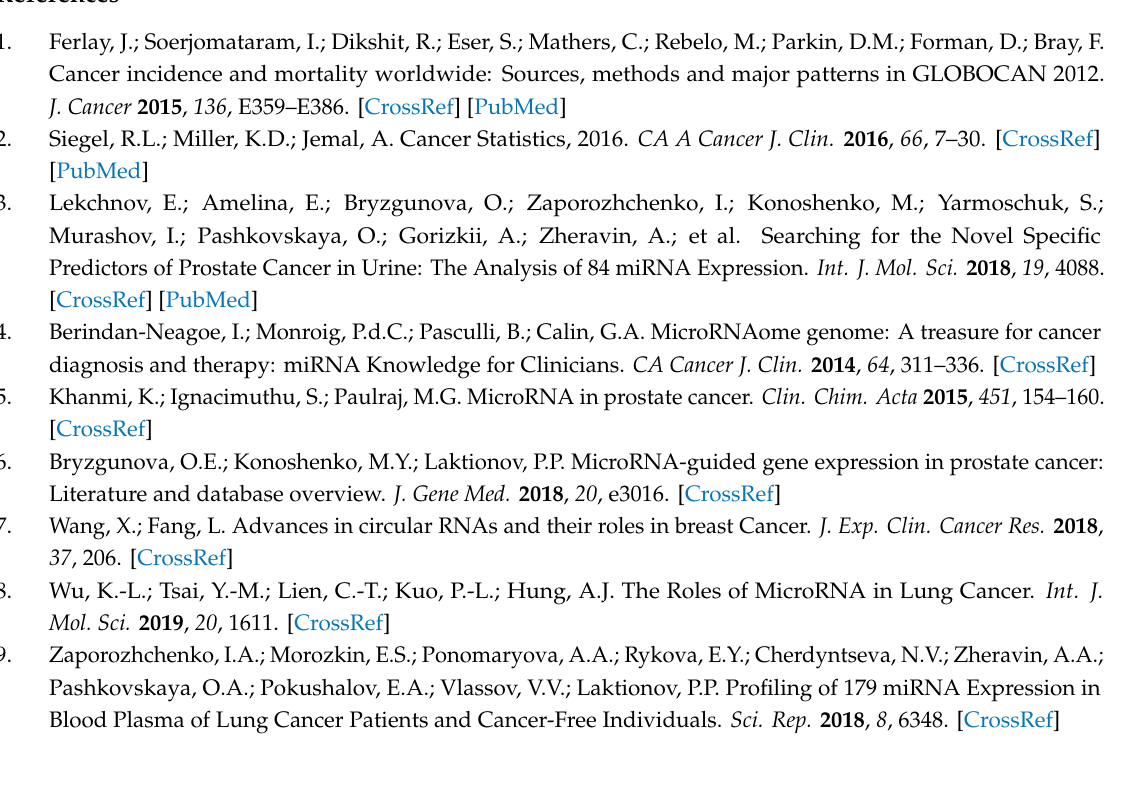
Supplementary Materials: The following are available online at http: // www.mdpi.com / 2075-4418 / 10 / 1 / 38 / s1, Table S1: Sequences of primers and probes used for reverse transcription and TaqMan qPCR, Figure S1: Examples of the qPCR curves for following miRNAs: miR-19b, miR-22, miR-92a, miR-378, miR-425 in urine EVs of healthy donor (A) BPH (B) and PCa (C) patients. Figure S2: Examples of the ROC curves for miRNA ratios with 100% specificity while discriminating PCa patients from healthy donors: (A) (100% sensitivity) miR19b / miR92a in urine EVs, (B) (90% sensitivity): miR375 / miR30e in urine EVs, C (80% sensitivity) miR22 / miR92a in urine EVs, (D) (70% sensitivity) miR378 / miR92a in urine EVs, (E) (60% sensitivity) miR205 / miR30e in blood plasma, (F) (40% sensitivity) miR125 / miR30e in blood plasma. Ratios like miR125 / miR30e in blood plasma were considered as low sensitive and are not shown in the manuscript